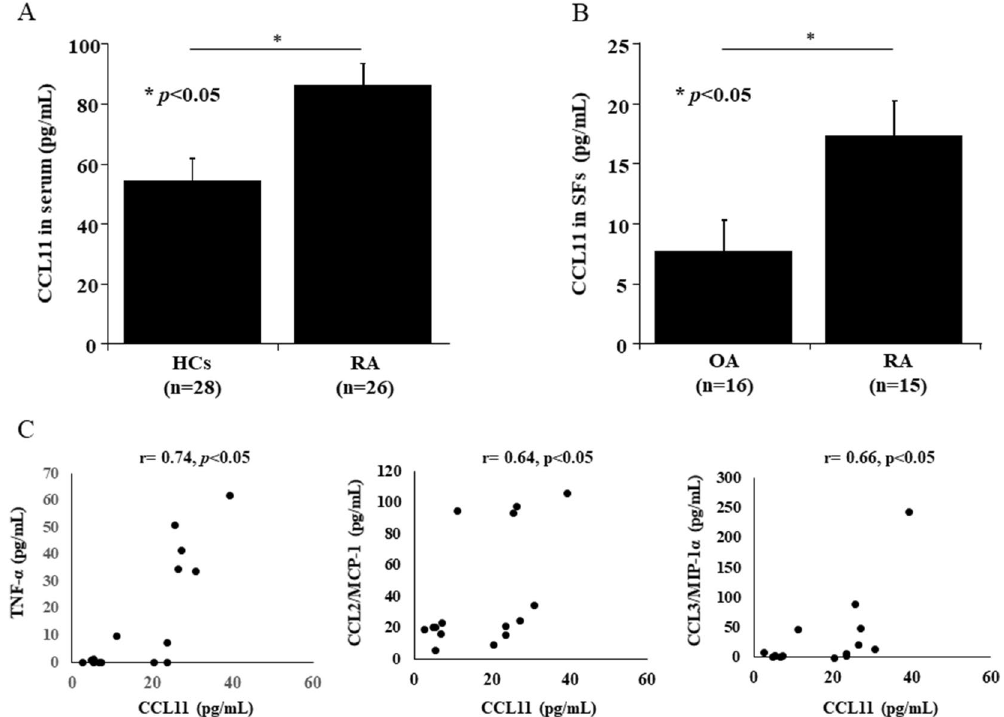
Figure 1. CCL11 is expressed in serum and synovial fluids (SFs) from rheumatoid arthritis (RA) patients. ( A ) The levels of CCL11 in the serum from RA patients (n = 26) were higher than those in the serum from healthy controls (HCs) (n = 28). ( B ) The levels of CCL11 in SFs from patients with RA (n = 15) were higher than those in SFs from patients with osteoarthritis (OA) (n = 16). The data values are expressed as the mean ± SEM. ( C ) The CCL11 levels were positively correlated with the levels of TNF-α, CCL2/MCP-1 and CCL3/MIP-1α in SFs of RA patients. * p < 0.05 was